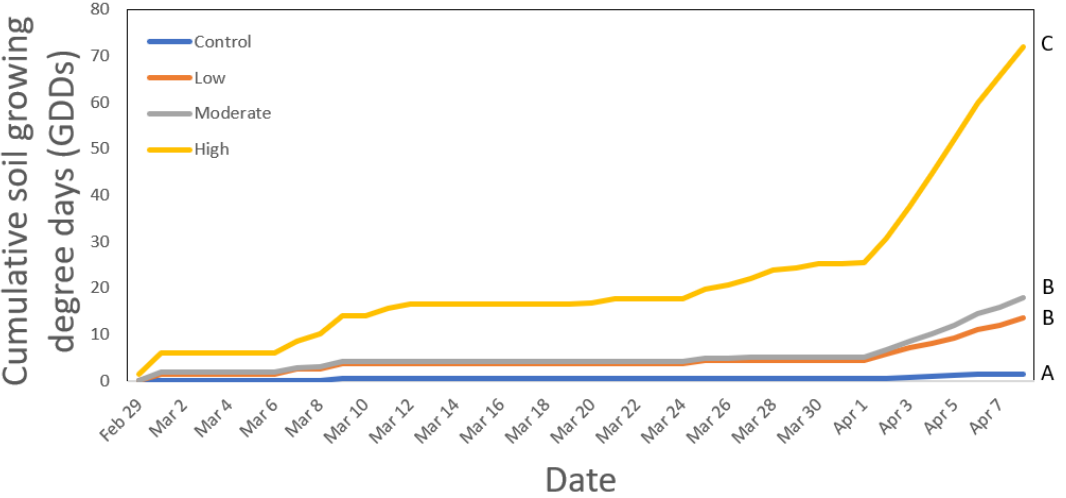
Figure 4. Cumulative soil growing degree days (GDDs) for each of the 4 experimental treatments (unburned control; level 1 = low severity; level 2 = moderate severity; level 3 = high severity) during the study period. Treatments with different uppercase letters had significant differences ( α = 0.05) for cumulative soil GDDs at the end of the study period.